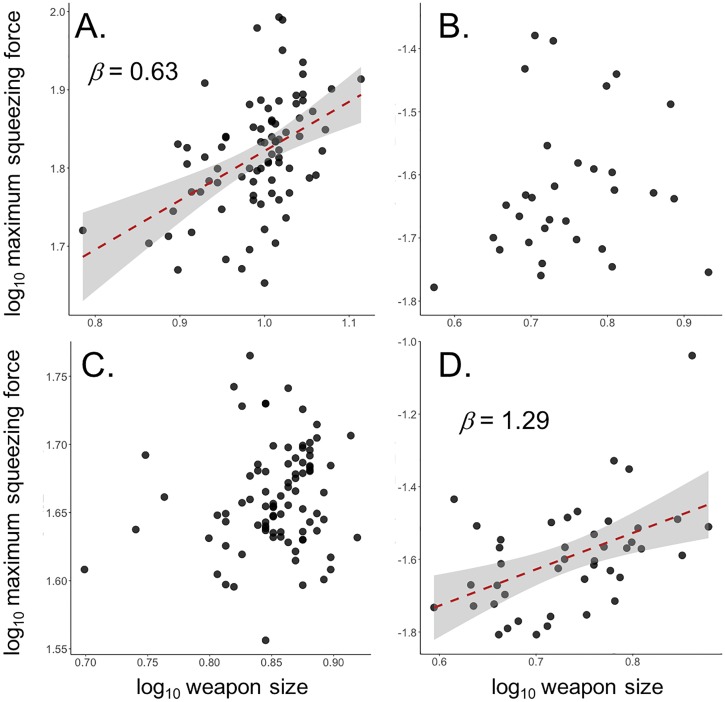
Relationship between maximum squeezing force and weapon size for A) male S. femorata, B) male N. femorata, C) female S. femorata, and D) female N. femorata.Red lines represent OLS regression. Shaded areas represent 95% confidence intervals around OLS regressions. Lines omitted for non-significant regressions.